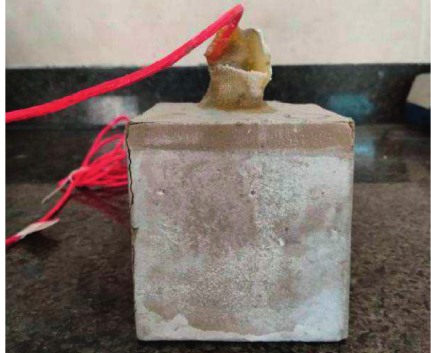
Figure 6: The cement soil sample cured using the seawater curing box.